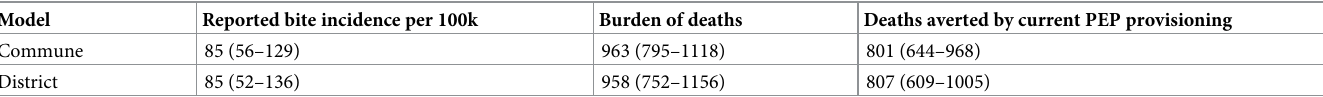
Table 2. Model predictions of average annual reported bite incidence, total deaths, and deaths averted at the national level for the two models (commune level and district level models with travel time predictor and an overdispersion parameter); 95% prediction interval in parentheses. Model Reported bite incidence per 100k Burden of deaths Deaths averted by current PEP